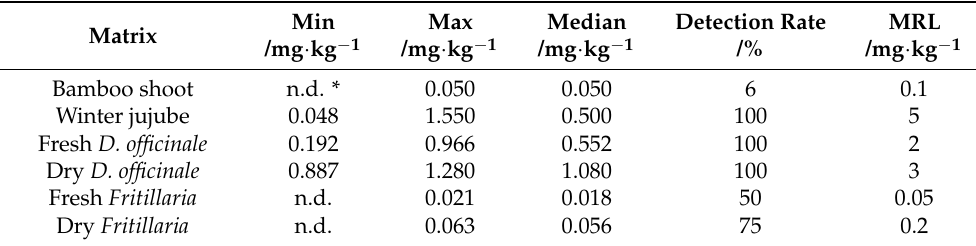
Table 3. Minimal, maximum, and median concentrations and detection rates of imidacloprid in collected